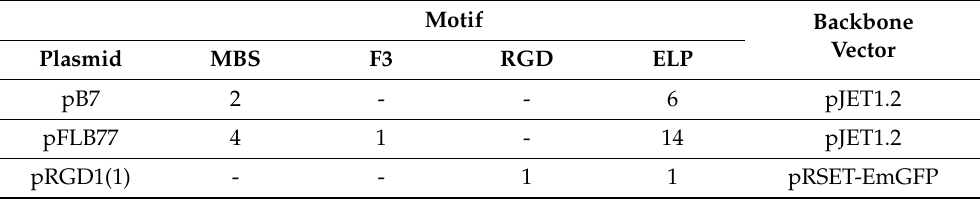
Table 3. The multiplying capacity of the initial plasmids for each essential motif per cloning cycle.